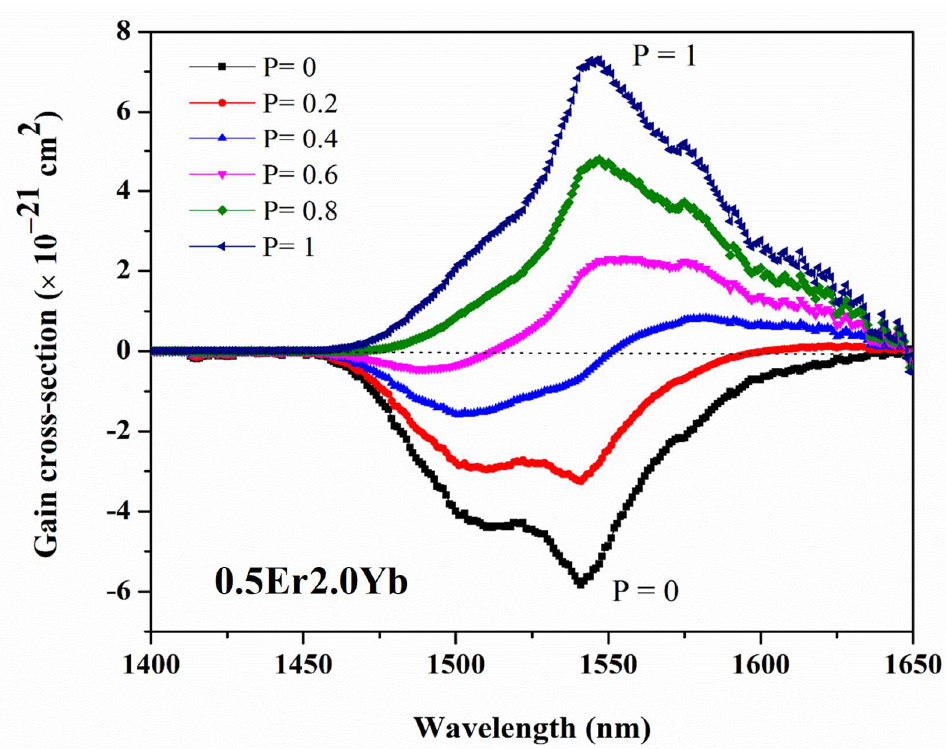
Figure 9. Gain cross-section profile of 4 I 13/2 → 4 I 15/2 transition in the range of 1400–1650 nm of 0.5Er ( upper ) and 0.5Er2.0Yb ( lower ) glasses used in the current